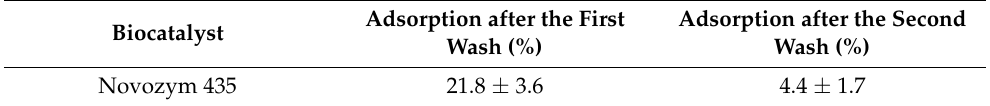
Table 4. Octanoic acid adsorption test results on Novozym 435.